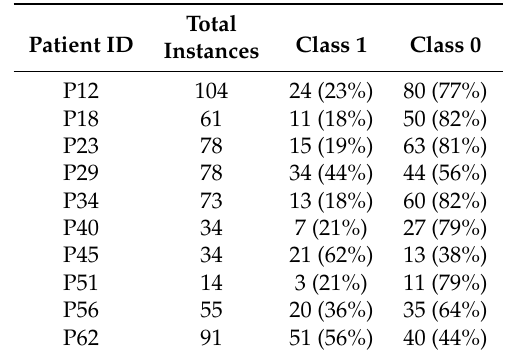
Table 2. Total number of instances for ten patients enrolled in the study. Class 0 is defined as a sleep period without hypoglycemia and Class 1 is defined as a sleep period with hypoglycemia.